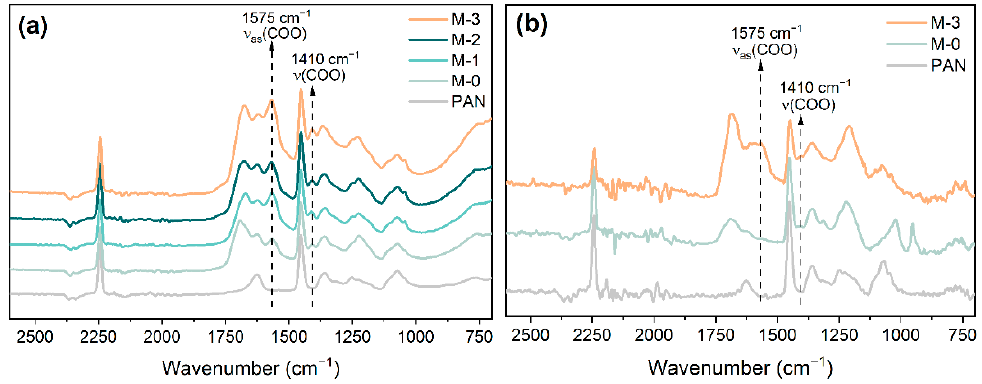
Figure 6. FTIR spectra of the ( a ) surface of the blank PAN, M-0, M-1, M-2, M-3 membranes, and ( b ) the reconstructed blank PAN, M-0 and M-3 membranes.